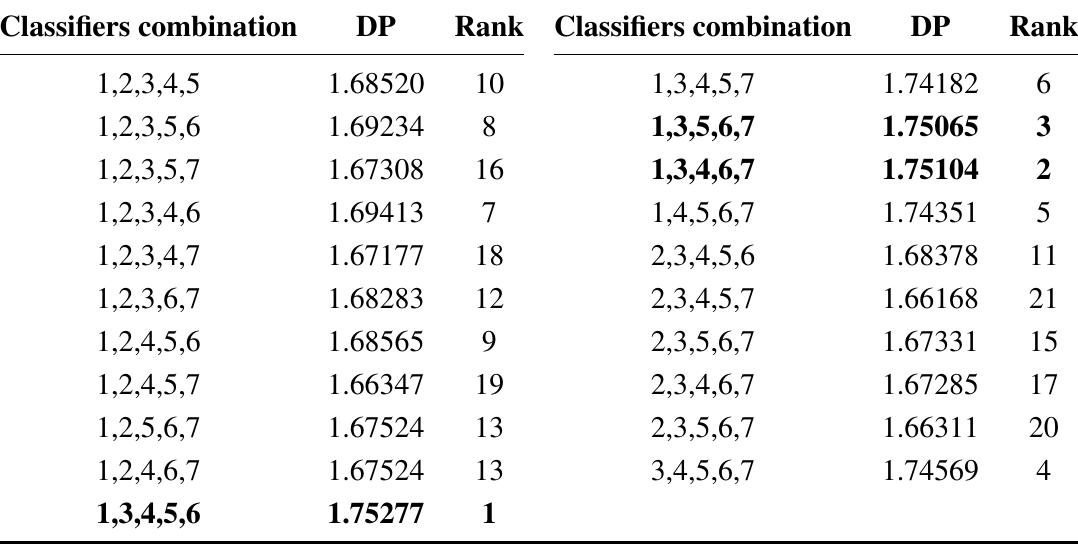
Table 8. Results of DP measure of all five classifiers’